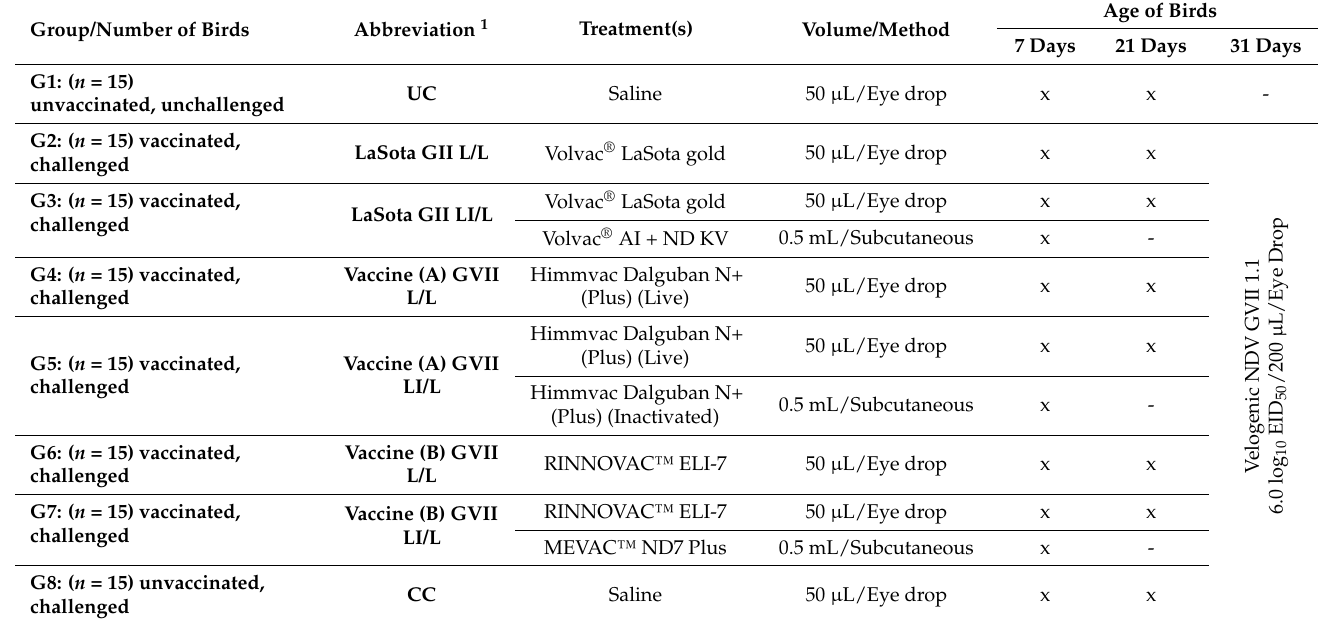
Table 1. Experimental design of vaccination schemes and post-vaccination challenge study.